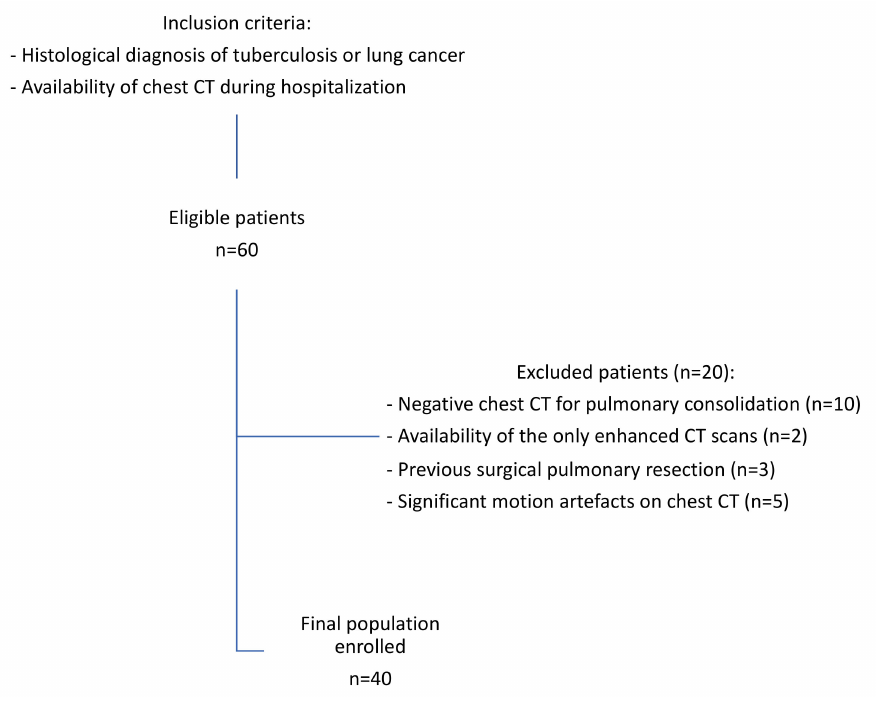
Figure 1. Patients’ enrollment flowchart.